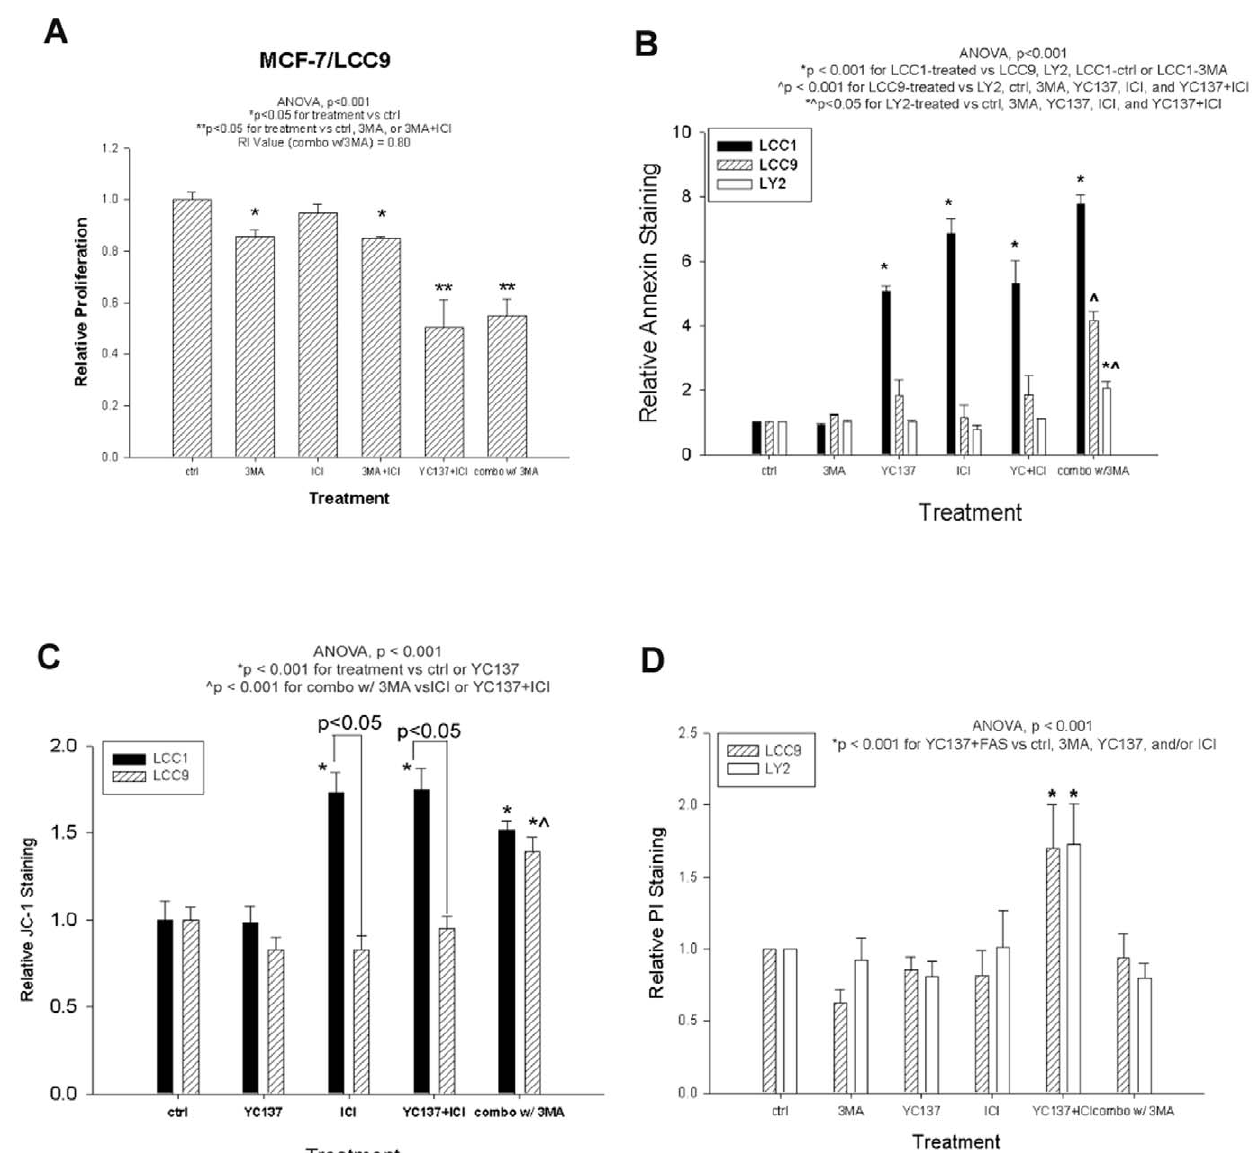
Figure 4. Increased apoptosis and decreased necrosis after BCL-W and BCL2 and autophagy inhibition. ( A ) Cells were treated with ICI, 3MA, YC137, or a combination of the three for 7-days. Bars represent the mean 6 SE of relative proliferation (normalized to empty vector control). ( B ) Cells were treated with YC137, ICI, 3MA, YC137 + ICI, or a combination of YC137, ICI, and 3MA for prior to Annexin V staining. Bars represent the mean 6 SE of the relative Annexin V staining (normalized to empty vector controls) for three independent experiments. ( C ) Cells were treated with ICI, 3MA, YC137, or a combination prior to JC-1 staining. ( D ) Cells were treated with YC137, ICI, 3MA, YC137 + ICI, or a combination of YC137, ICI, and 3MA prior to PI staining. Bars represent the mean 6 SE of the relative PI staining (normalized to empty vector controls) for three independent